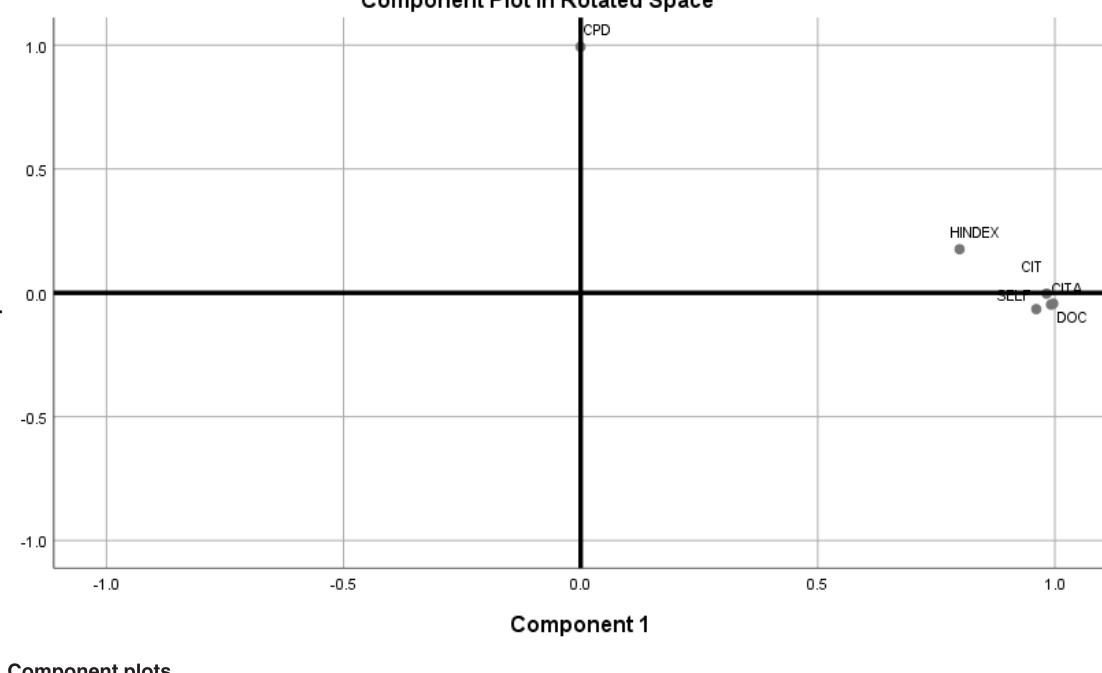
Figure 1. Component